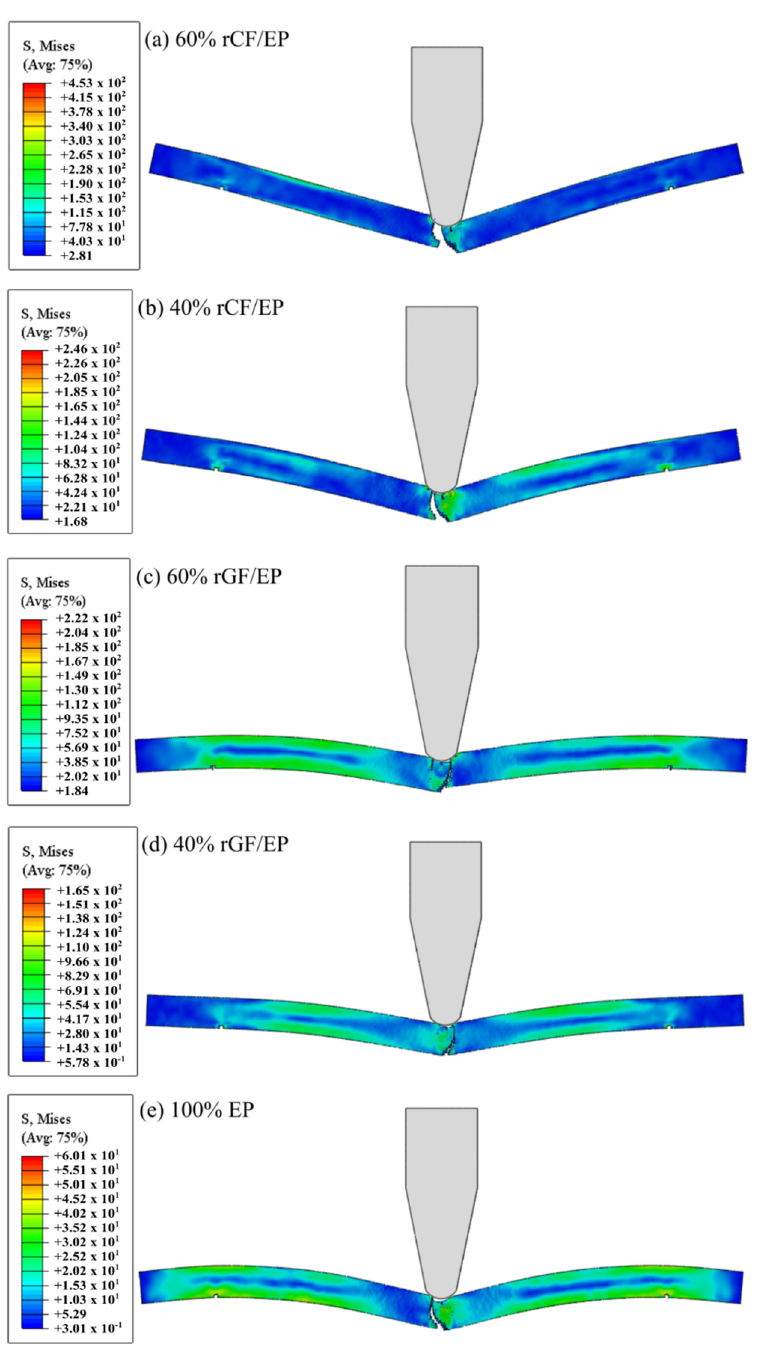
Figure 12. Numerical IT results using von Mises stress distribution: ( a ) 60% rCF/EP; ( b ) 40% rCF/EP;